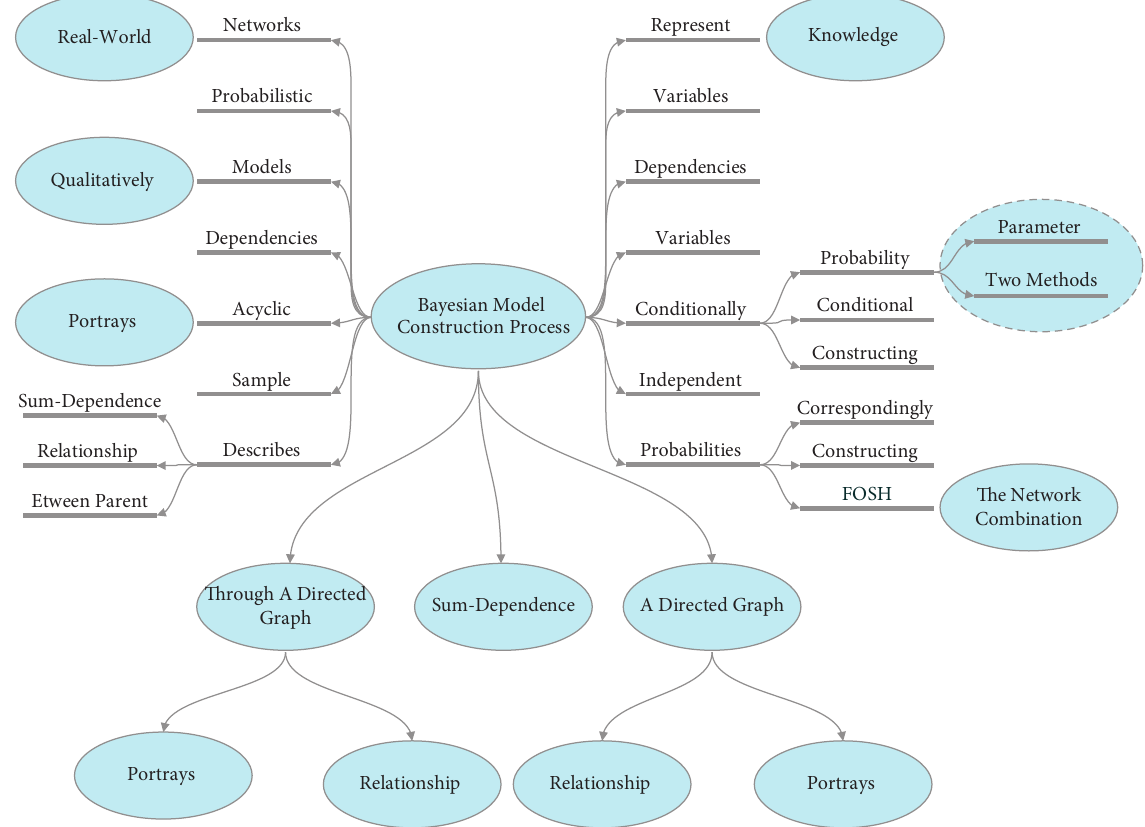
Figure 1: Bayesian model construction